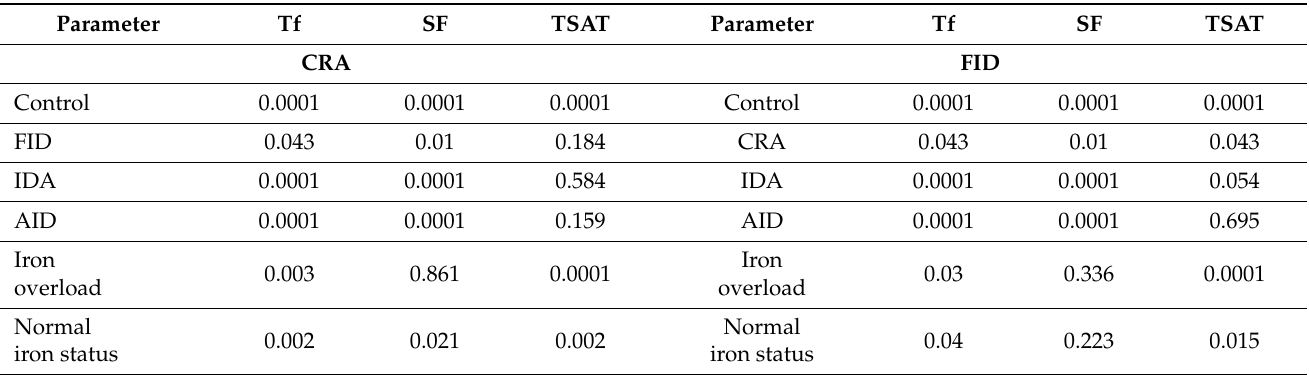
Table 5. Significance levels of differences ( p -value) in transferrin, serum ferritin, and transferrin saturation values between patients with FID or CRA and patients with other types of iron homeostasis and the